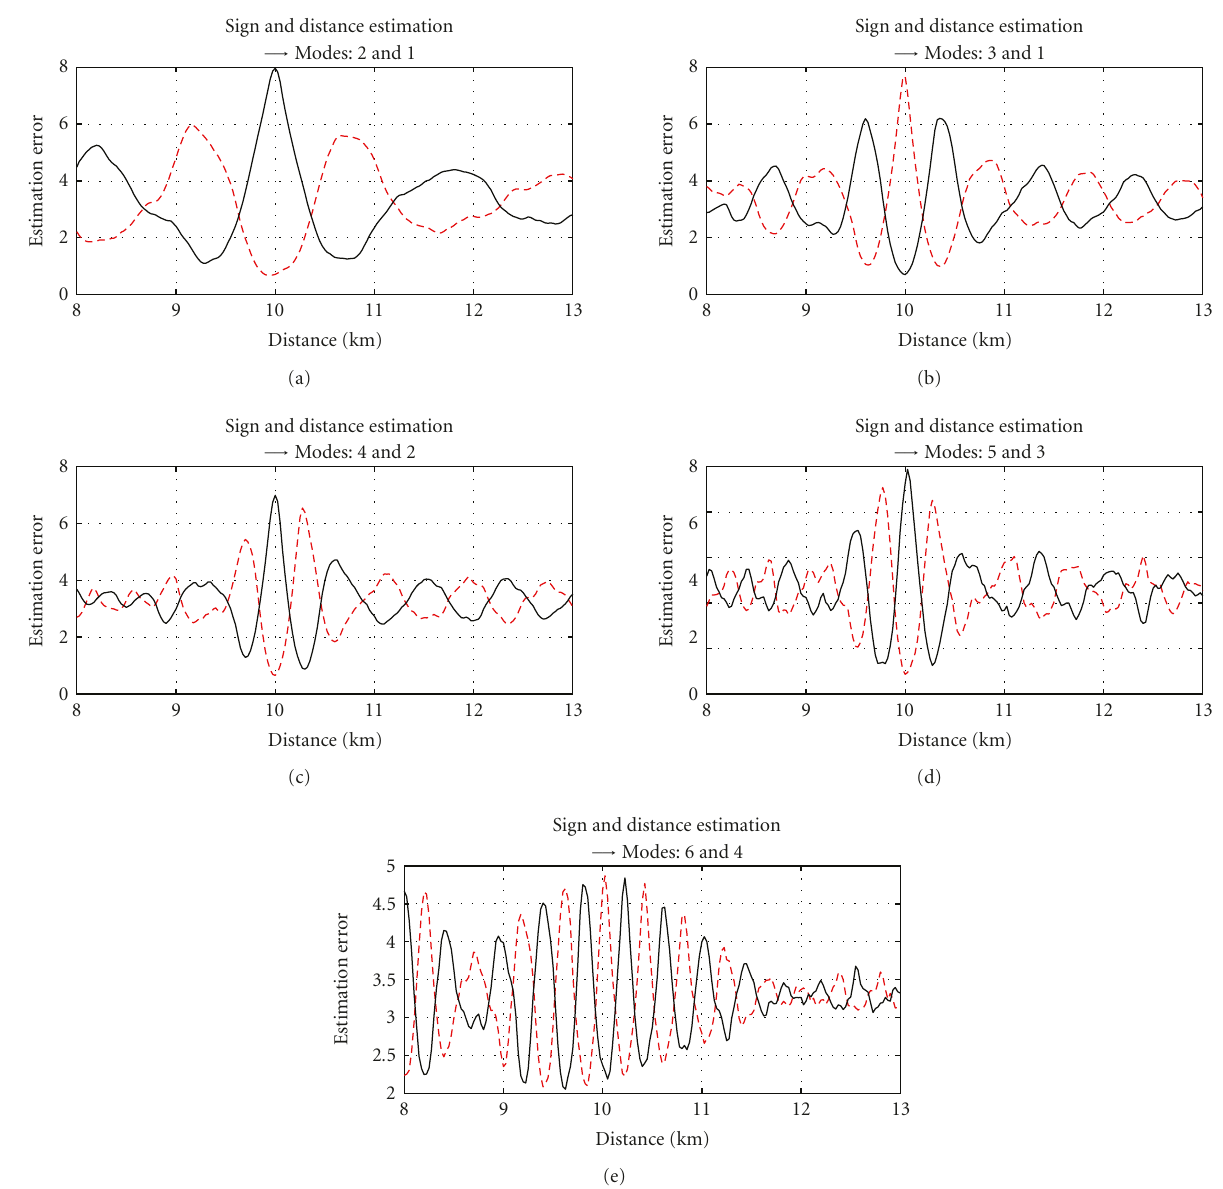
Figure 15: Cost functions C of sign-distance estimator in a single hydrophone scenario. The results are given for mode couples: (2,1), (3,1), (4,2), (5,3), and (6,4) and radial distance search zone r ∈ (8,13) km. The source is 10 km distant from the hydrophone. Solid and dashed lines are given for two possible values of (cid:24) Δ φ ( m , n , z s ): 0 and π .